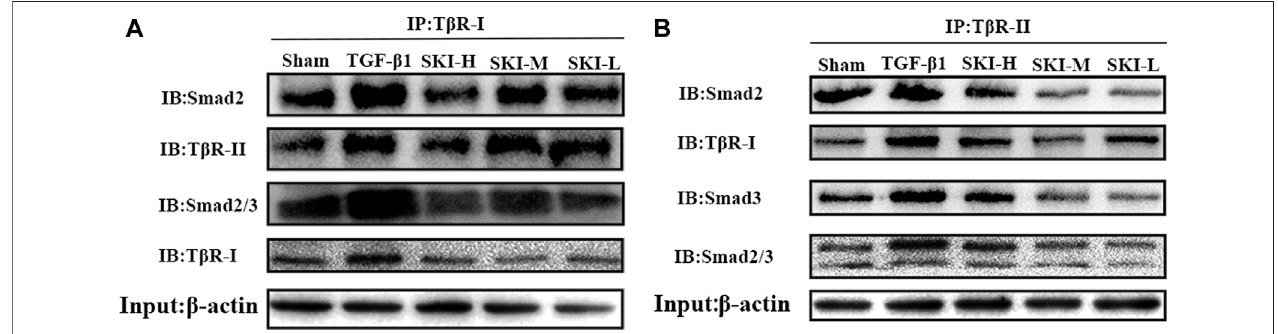
FIGURE 11 | Effects of Shenkang injection on binding of T β R-I/II to Smad2 and Smad3 proteins. (A) HK-2 cell lysate was immunoprecipitated (IP) with T β R-I antibody,andthenSmad2andT β R-II,Smad2/3andT β R-IantibodiesperformedwithtoWesternblotting(IB). (B) HK-2celllysatewasimmunoprecipitated(IP)withT β R-